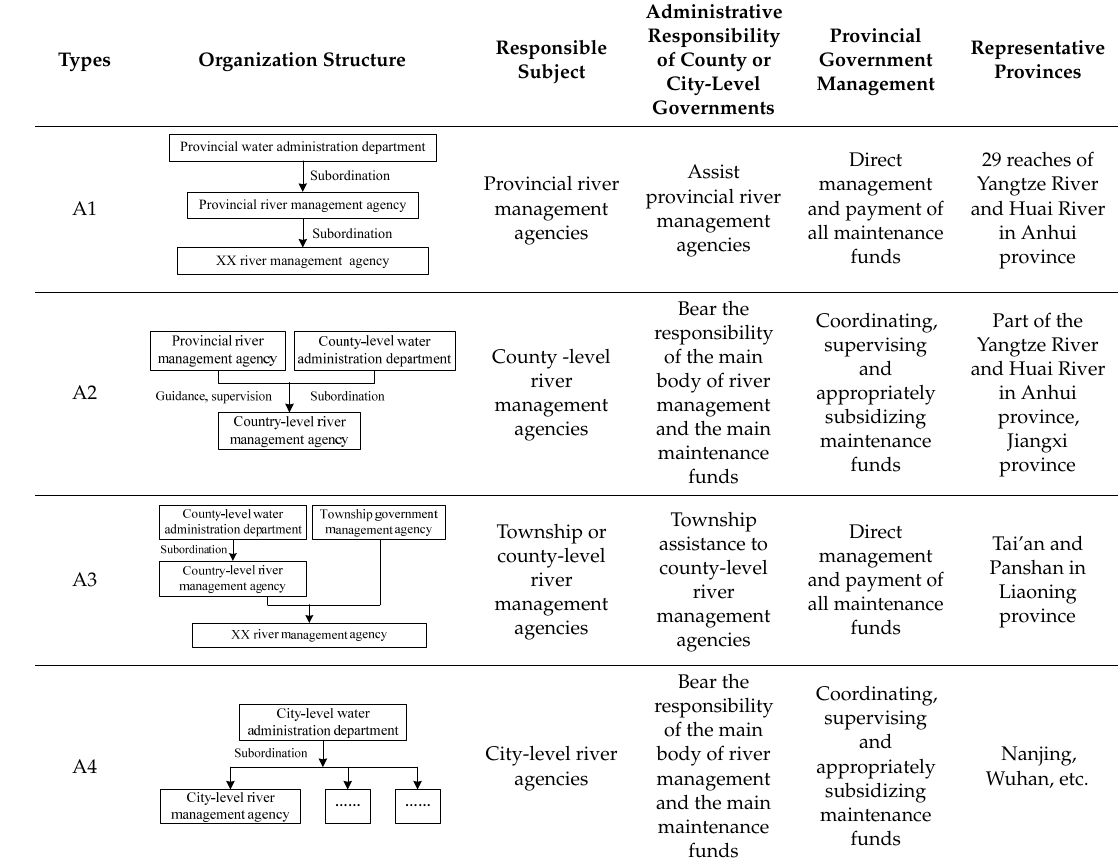
Table 1. Comparisons of organization modes of river embankment operation management.